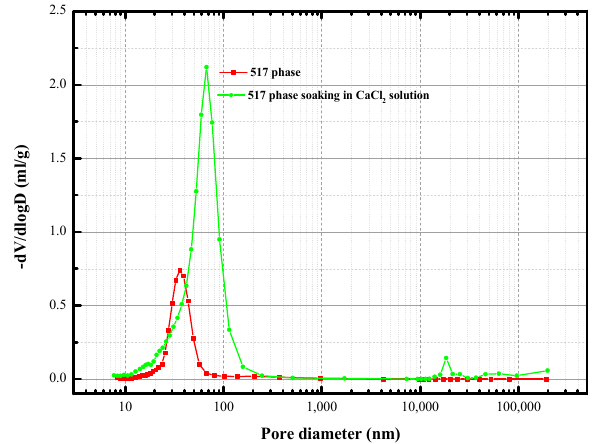
Figure 9. Cumulative porosity of hardened paste of 517 phase before and after immersion in CaCl 2 solution.